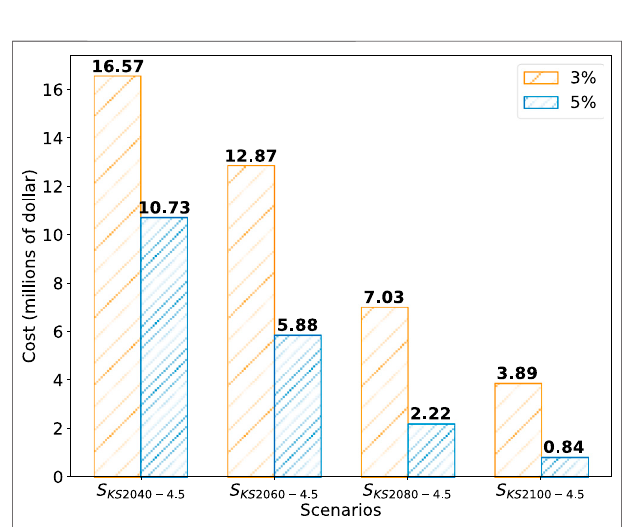
FIGURE 19 | Hurricane damage cost when the retro fi t is done at the present time all at once (B.1).